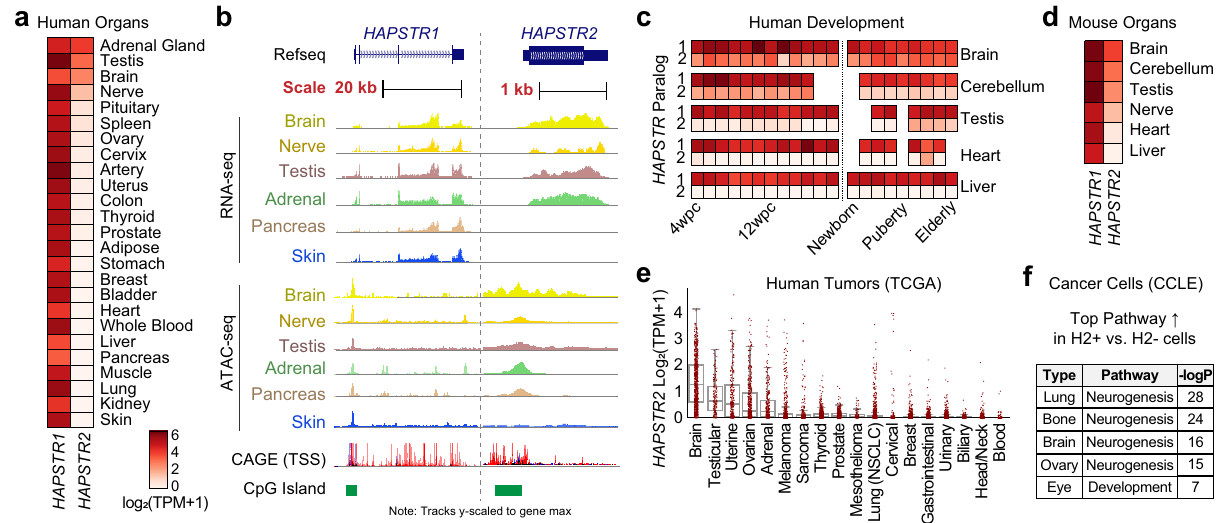
Fig. 2 | Tissue-restricted expression of mammalian HAPSTR2 . a Transcript abundanceof HAPSTR1 and HAPSTR2 intheindicatedhumantissues;GTExRNA-seq data. TPM, transcripts per million. Same heatmap scale across other subpanels. b Gene expression, chromatin accessibility, transcription start sites, and CpG islands at human HAPSTR1 and HAPSTR2 gene loci; GTEx, ENCODE, and